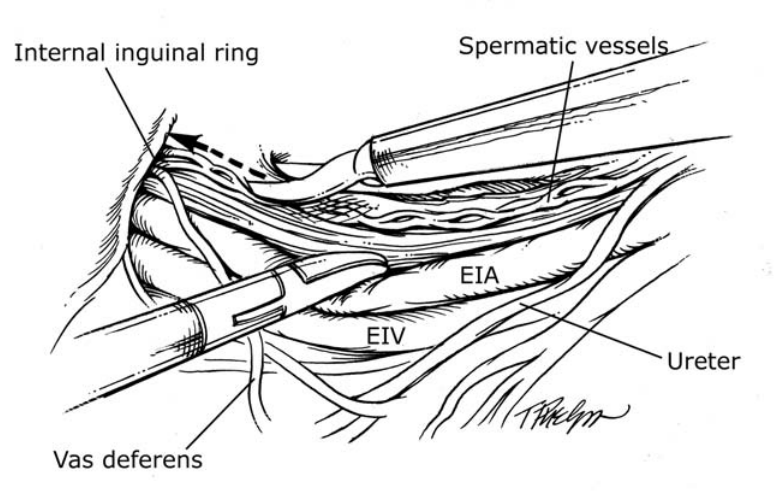
Figure 2 – The spermatic vessels are dissected distally in the direction of the internal inguinal ring (arrow – dotted line). Observe the close relationship with the iliac vessels, which must be identified to avoid inadvertent injury (EIA = external iliac artery; EIV = external iliac